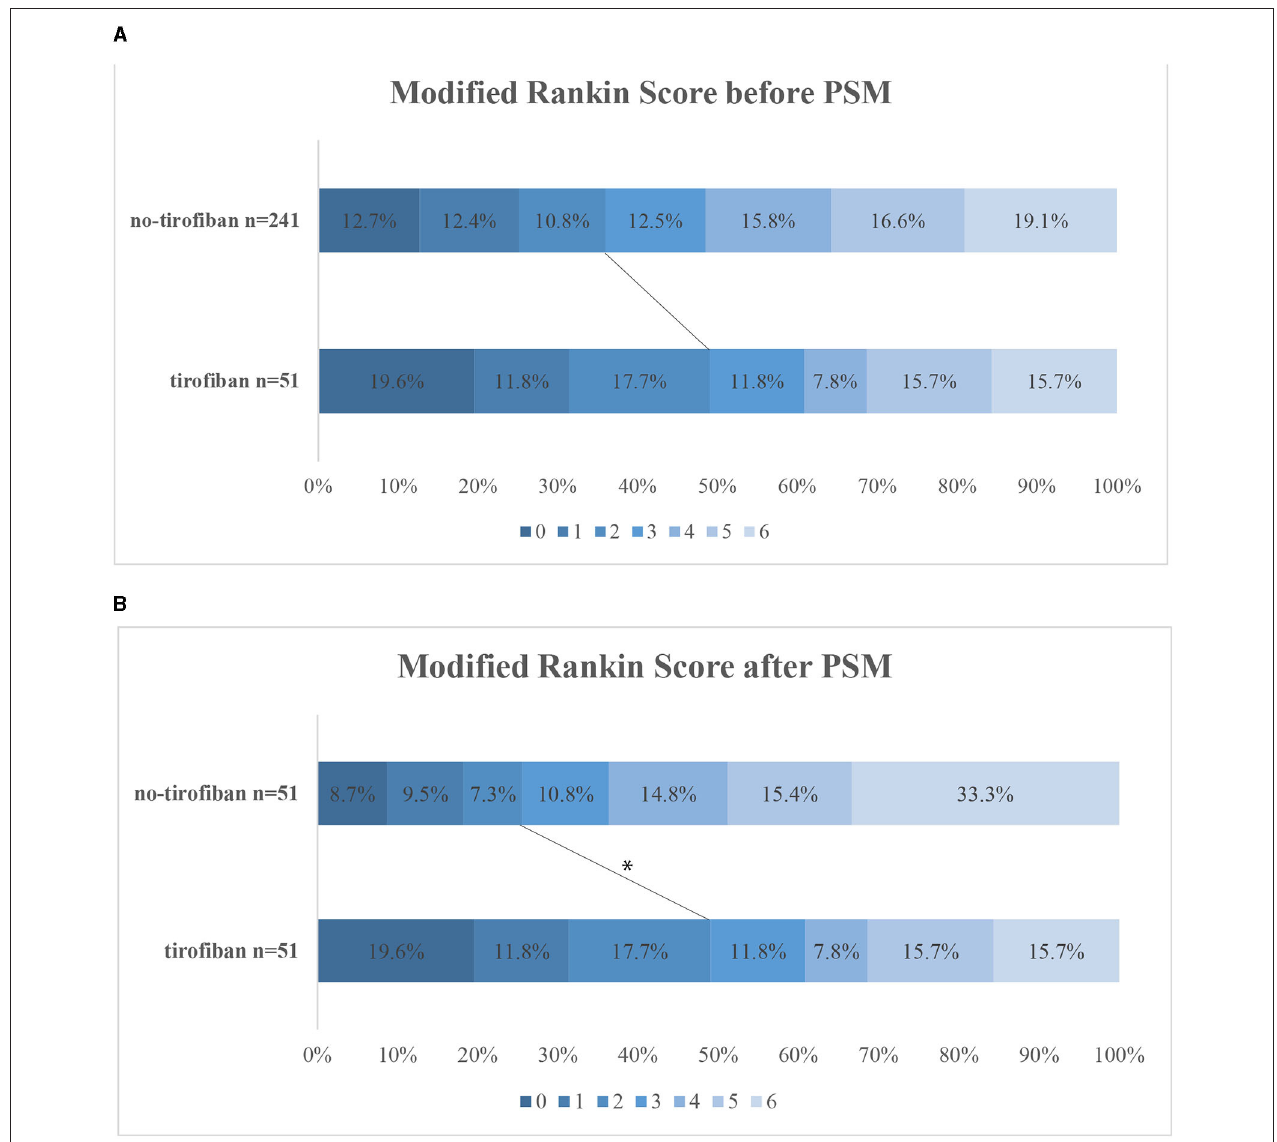
FIGURE 1 | Distribution of mRS at 3 months categories before PSM (A) and after PSM (B) . The lines indicate differences in favorable outcome (mRS 0–2) between groups. * p < 0.05. mRS, modified Rankin Scale; PSM, propensity score matching.